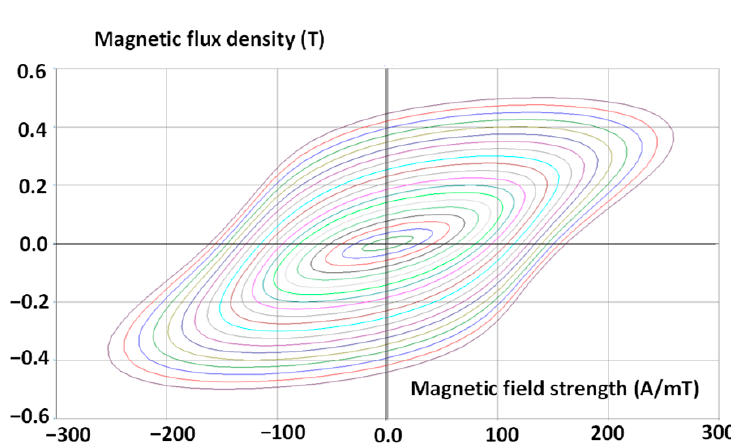
Figure 10. Exemplary samples.